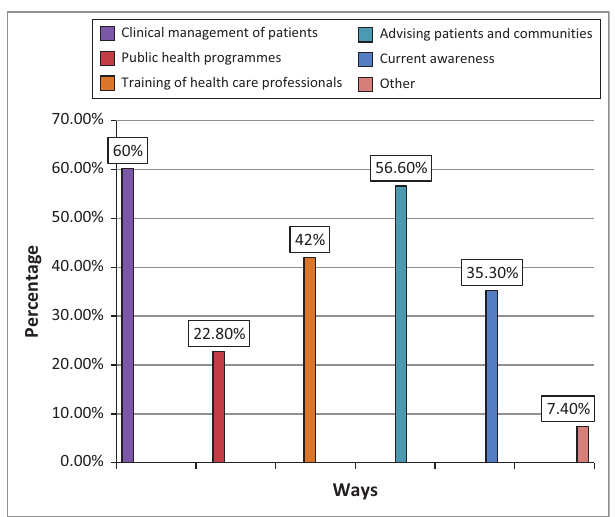
FIGURE 1: Ways in which current accessed information is used by professional nurses in